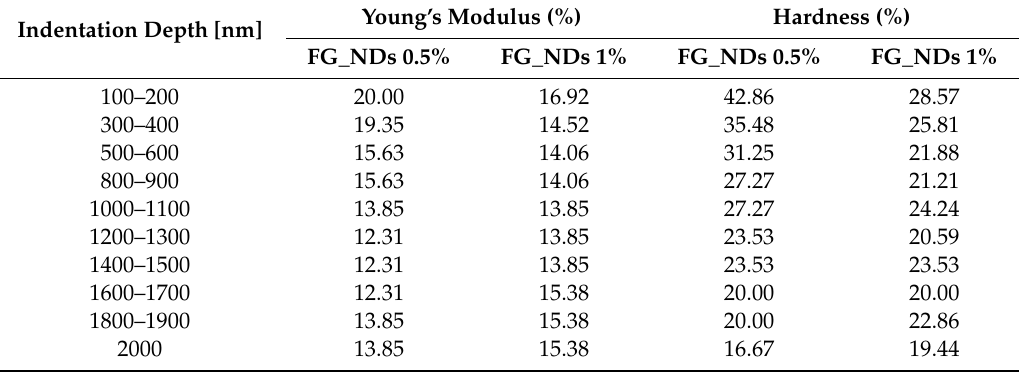
Table 1. The percent of mechanical properties increase with addition of NDs in respect to the values obtained for